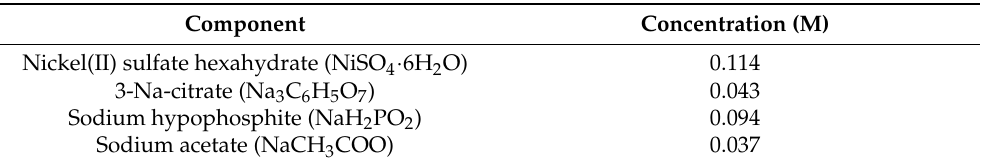
Table 3. The electroless Ni–P solution composition (pH = 4–6). Adapted with permission from [43].